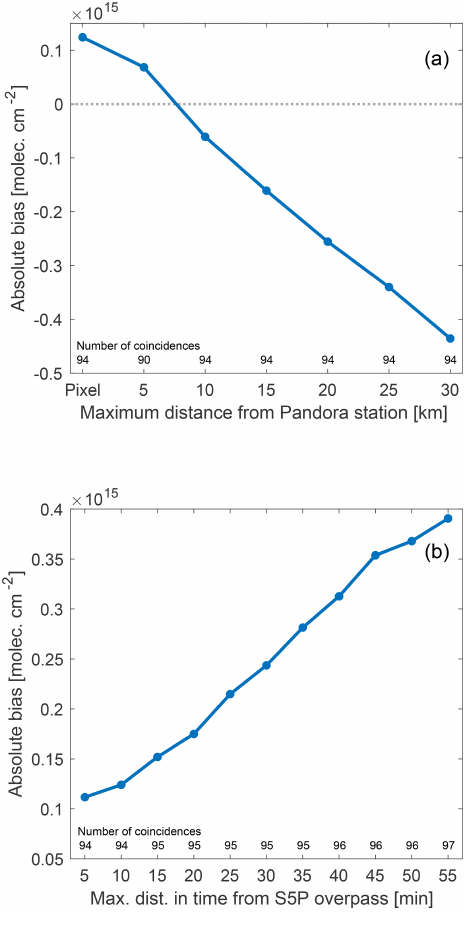
Figure 4. Mean absolute difference between TROPOMI summed and Pandora total columns as a function of the maximum distance between the centre of the pixel and the ground-based station (a) , and as a function of the maximum time difference from the TROPOMI overpass (b) . The number of coincidences for different collocation criteria are shown above the x axis. Note that in (a) we also re- quire that the TROPOMI pixel above Pandora station contains a valid measurement (QA value > 0 . 75). Thus the number of coinci- dences does not increase with